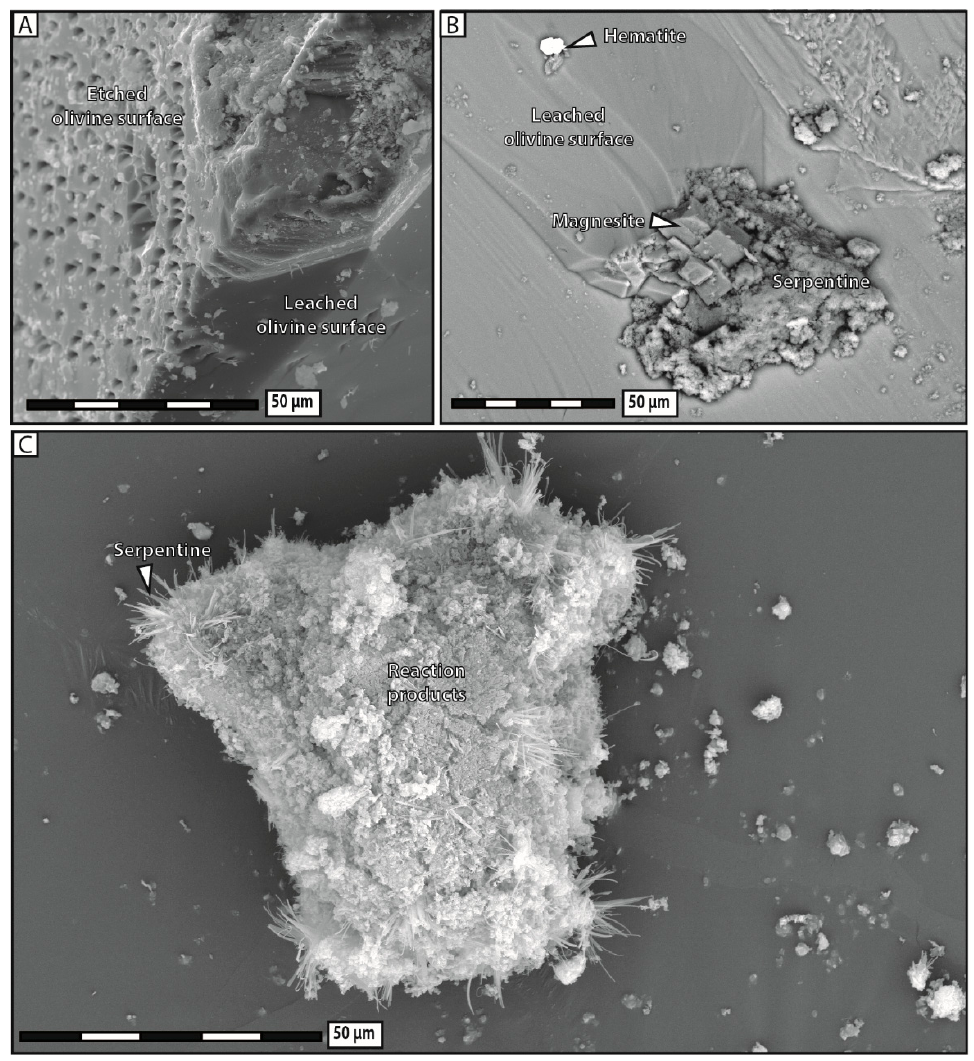
Figure 8. SEM images after reaction in NaHCO 3 solution. ( A ) Contact zone between etch-pitted and leached olivine surfaces. ( B ) Cluster of reaction products on top of leached olivine. ( C ) Single aggregate of reaction products consisting in a mixture of serpentine, magnesite, dolomite and hematite. ( B ) is for t = 3 months (run # 4), and ( A and C ) for t = 12 months (run # 6).